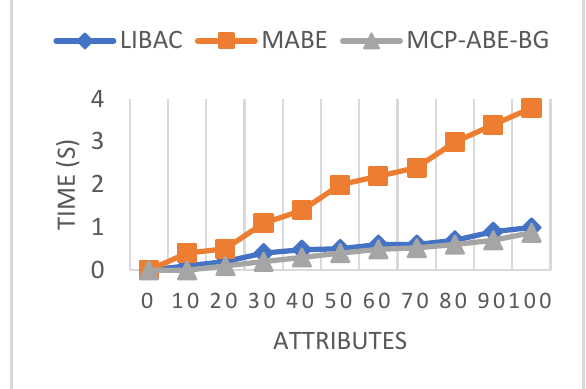
Figure 6. Key generation time comparison.